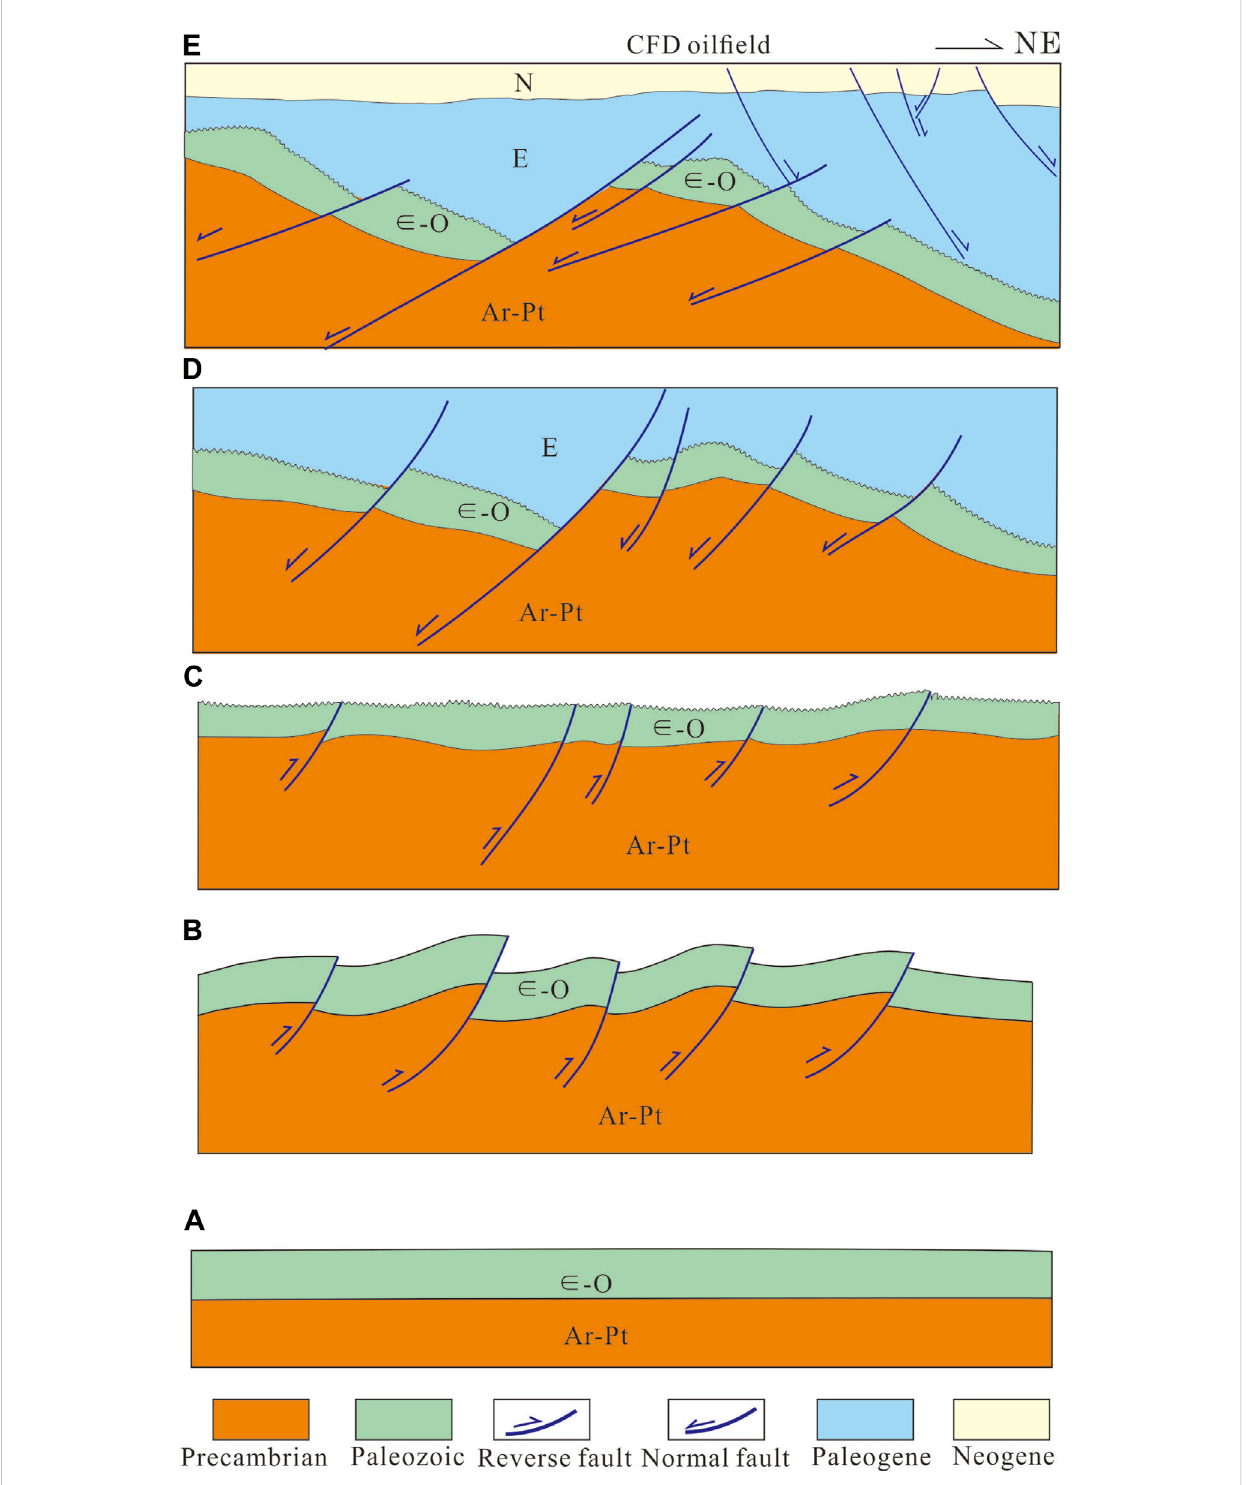
FIGURE 7 (A) :ThestabletectonicbackgroundbeforetheIndosinianmovement; (B) Developmentofthethrust-relatedfoldsduringtheIndosinianmovement; (C) Continuous uplift and denudation during the Yanshan movement; (D,E) Buried hills are gradually buried and shaped during the Cenozoic